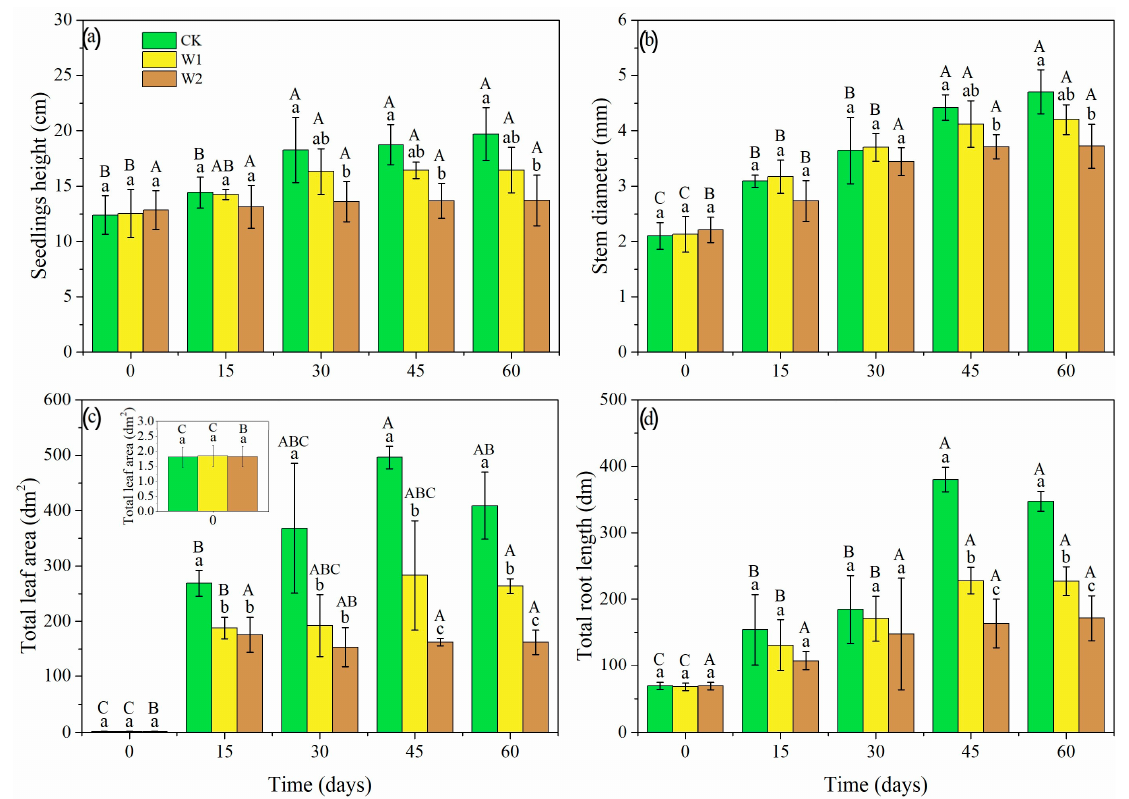
Figure 4. Seedling height ( a ), stem diameter ( b ), total leaf area ( c ), and total root length ( d ) of Mongolian oak seedlings under different drought intensities and durations. Uppercase letters represent the significant differences in the same treatment at different times ( p < 0.05), and lowercase letters represent the significant differences between different treatments at the same time ( p <